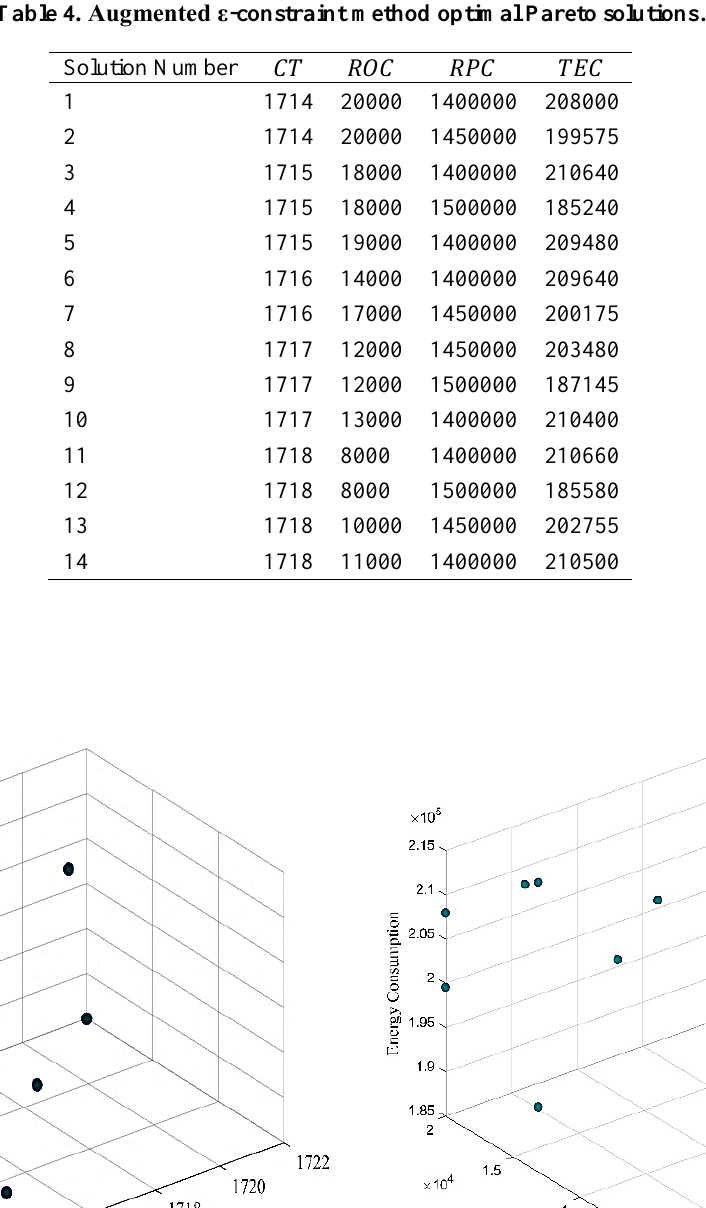
Figure 3. Operational optimal solutions of ε-augmented constraint.